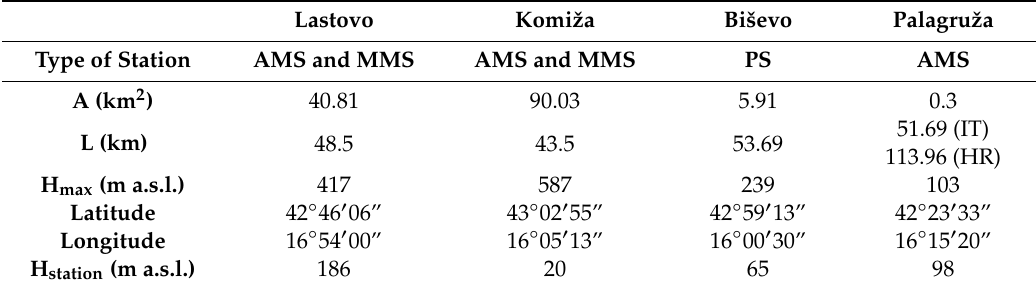
Table 1. Characteristics of the investigated islands and their meteorological stations. Lastovo